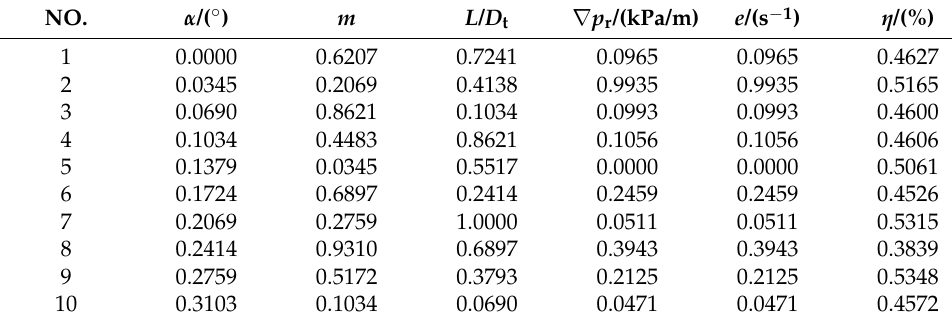
Table 3. Sample space of multi-objective optimization after data